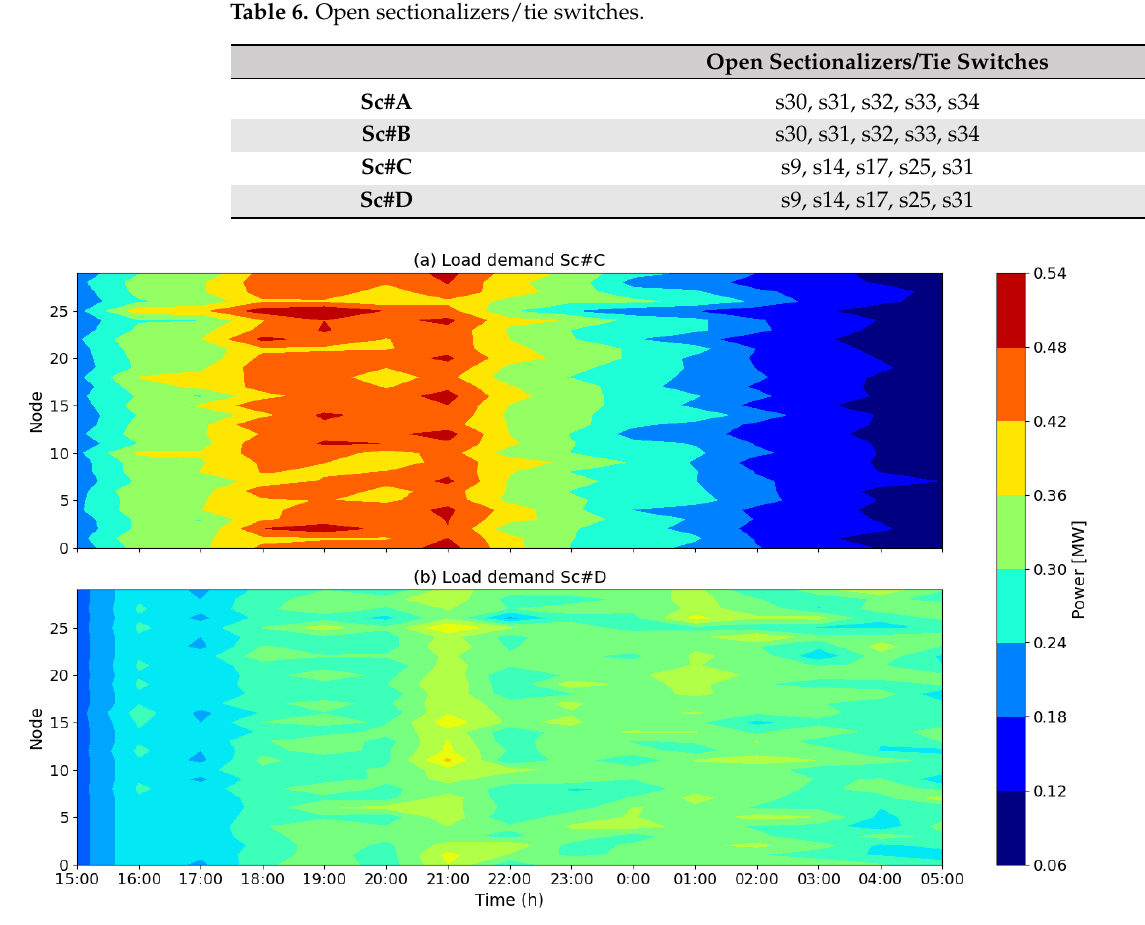
Figure 10. Load demand for: ( a ) Sc#C, ( b ) Sc#D.